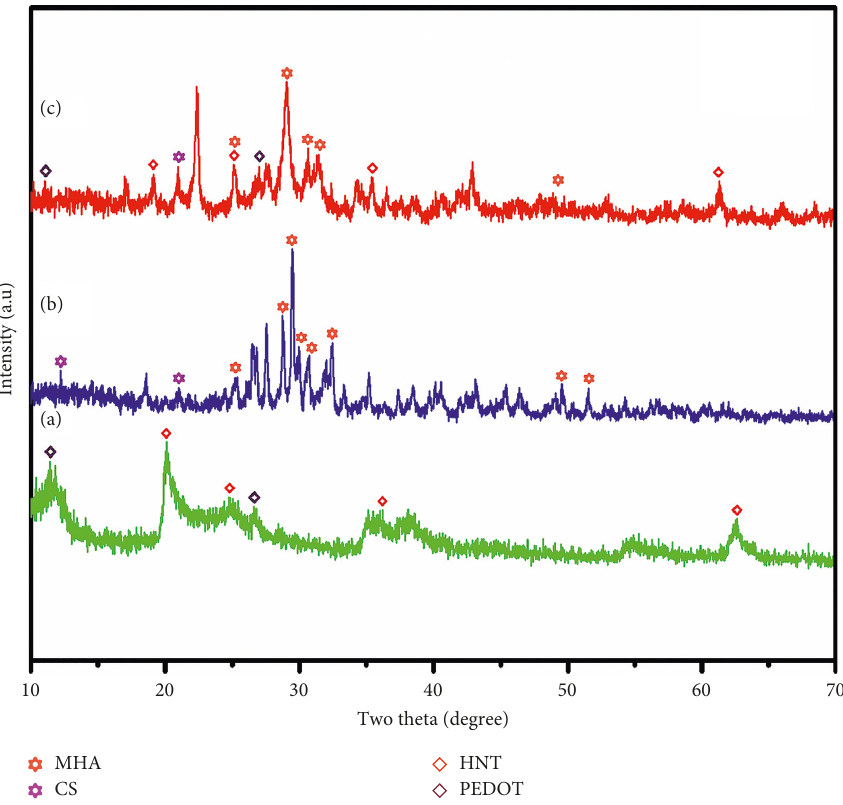
Figure 3: XRD patterns of (a) PEDOT-HNT, (b) CS-MHA, and (c) PEDOT-HNT/CS-MHA bilayer composite